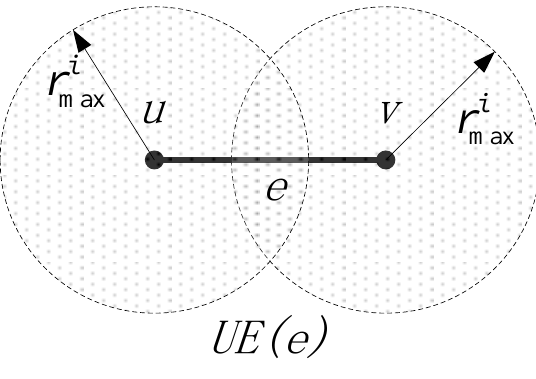
Figure 4. The readjustment link set.